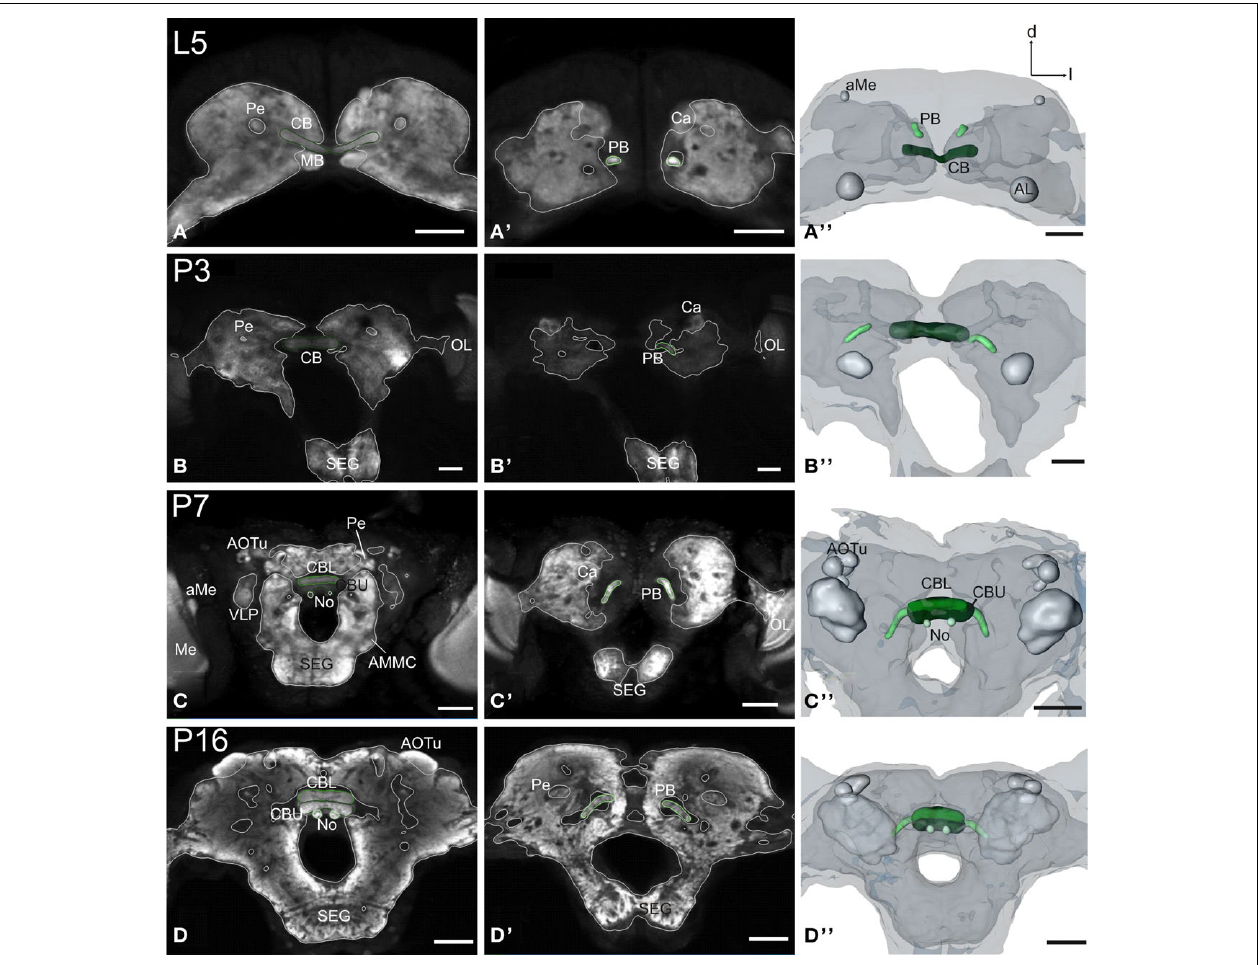
becomes thicker. (C–C ′′ ) Stage P7: a lower (CBL) and upper (CBU) subunit are discernable. The noduli (No) appear antero-ventrally of the CB. The PB reaches its fi nal position with its lateral ends pointing postero-ventrally. (D–D ′′ ) Stage P16: the central complex has further increased in